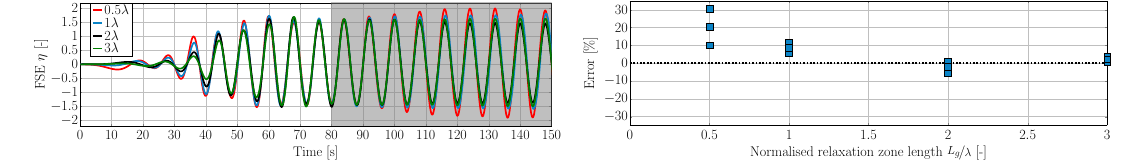
σ (cid:101) ( b ) for the different lengths L g . H msw ± ¯ Hmsw